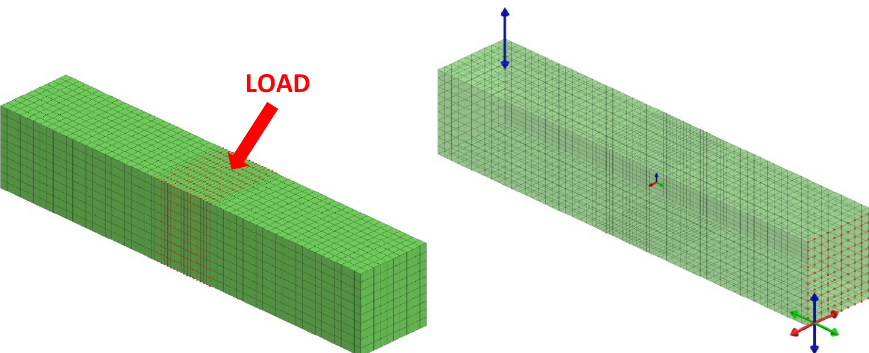
Figure 3. Numerical model with marked area of nodes on which the heat cycle of the heating process (“LOAD”) was given and the boundary conditions of sample clamping.